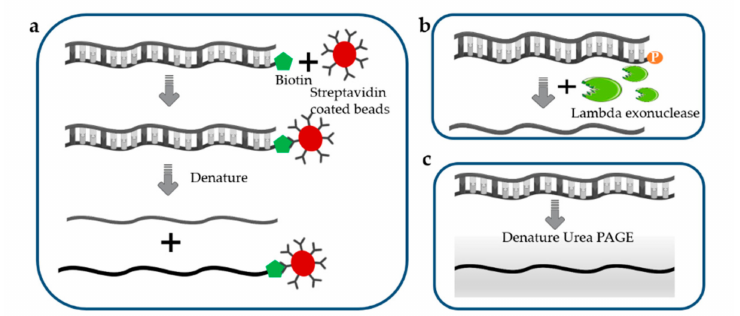
Figure 3. Direct separation of ssDNA. ( a ) Biotin–streptavidin separation of ssDNA; ( b ) Lambda exonuclease digestion; ( c ) Denaturing urea polyacrylamide gel